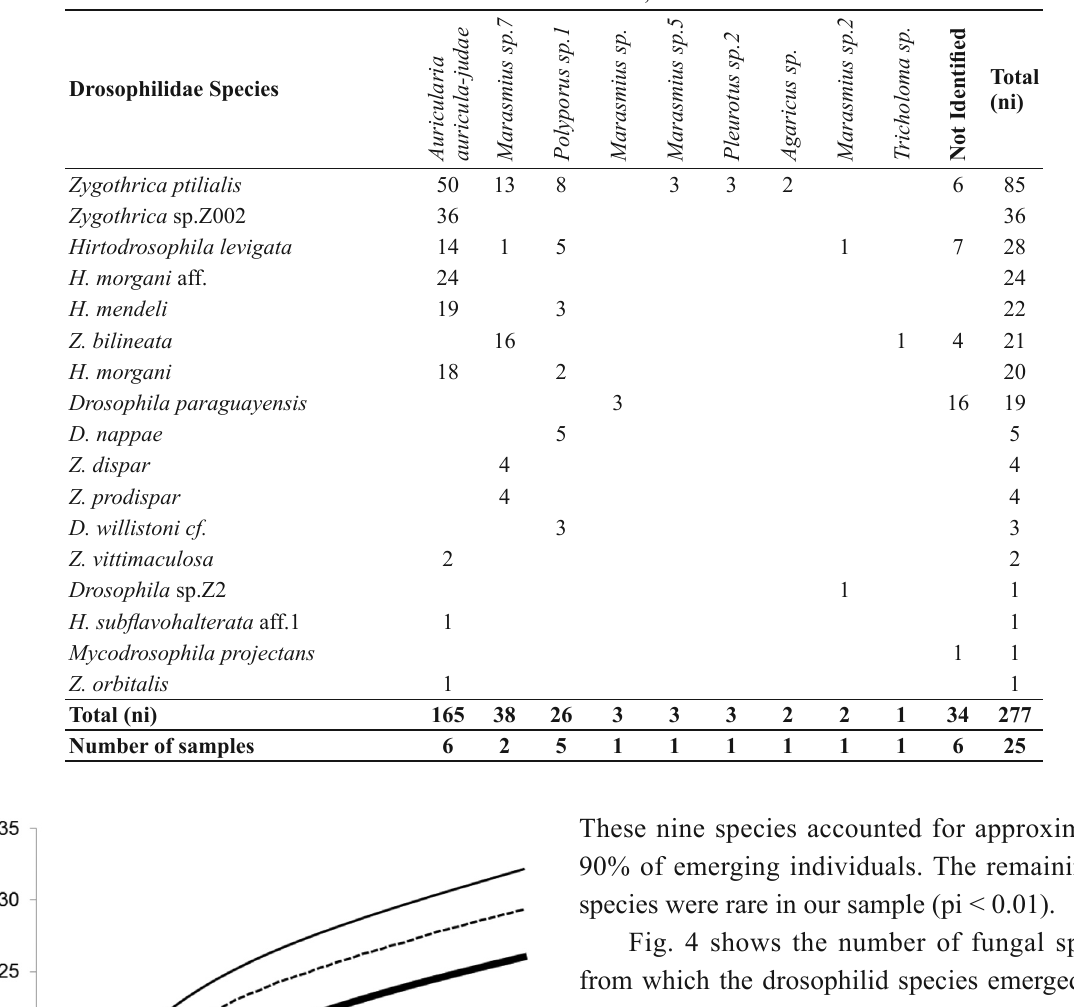
Absolute abundance of drosophilid species sampled as adults on Basidiomycetes fungal species in Horto Botânico Irmão Teodoro Luís, southern Brazil.